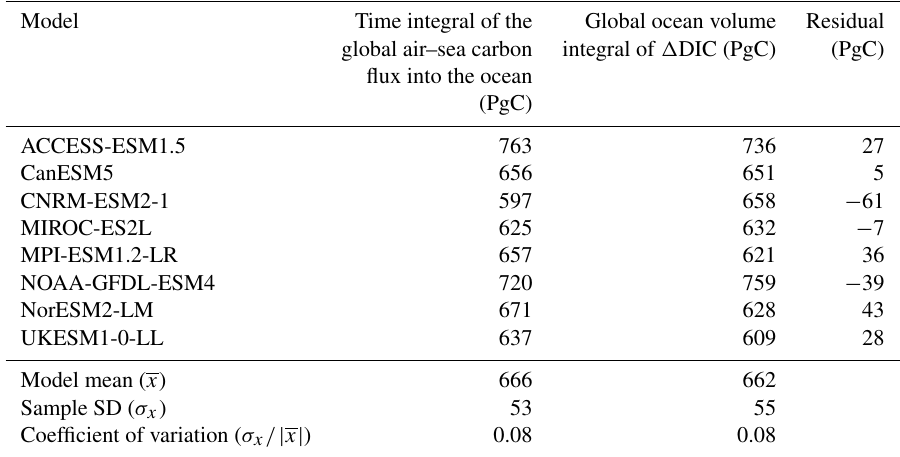
Table A2. Estimate of the change in the ocean carbon inventory (PgC) expected from a time integral of the global air–sea carbon flux into the ocean versus the volume integral of the change in the dissolved inorganic carbon, together with the small residual. The time integral of the air–sea carbon flux provides the dominant contribution to the change in the ocean carbon inventory, although there is a small mismatch due to the land-to-ocean carbon flux from river runoff and the ocean-to-land carbon flux from carbon burial in ocean sediments.